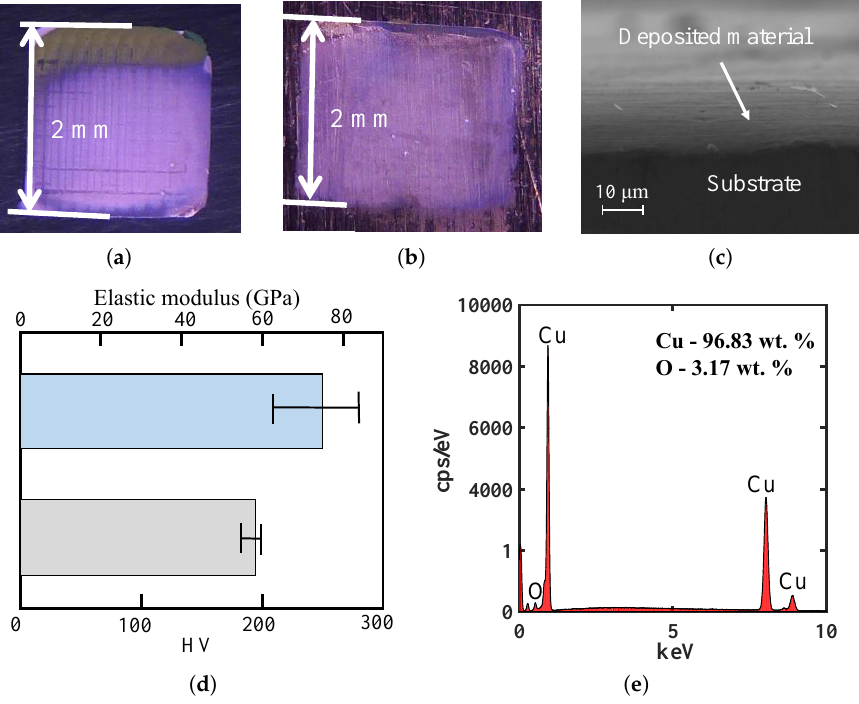
Figure 7. ( a ) A copper square printed on the polished brass substrate for two layers. ( b ) A copper square printed on the unpolished copper substrate for two layers. ( c ) SEM image of the side view of a copper square printed on the brass substrate for 32 layers. ( d ) Elastic modulus and Vickers hardness for the printed copper square. ( e ) EDX of the printed copper